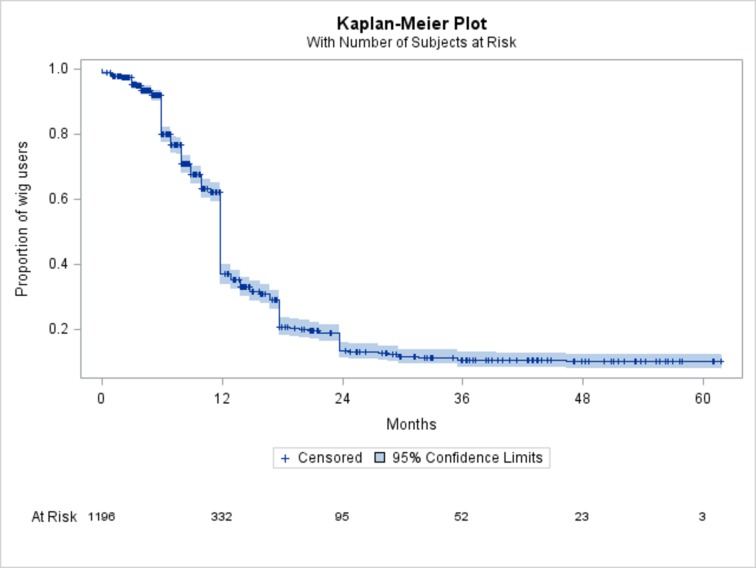
Period of wig use.The wig usage rates at 12, 24 and 36 months were estimated to be 37.3%, 13.5 and 10.3% based on the Kaplan-Meier plot.